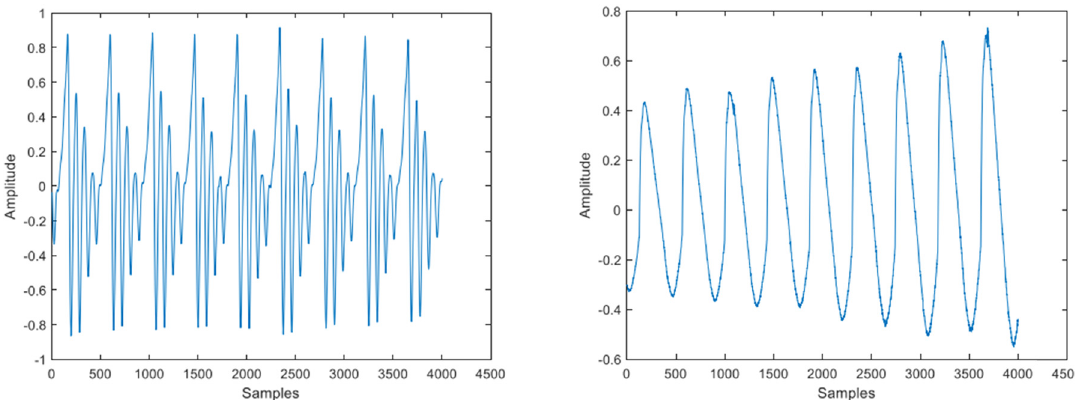
Figure 2: Voice and EGG signal examples from the SVD database [ 13 ]